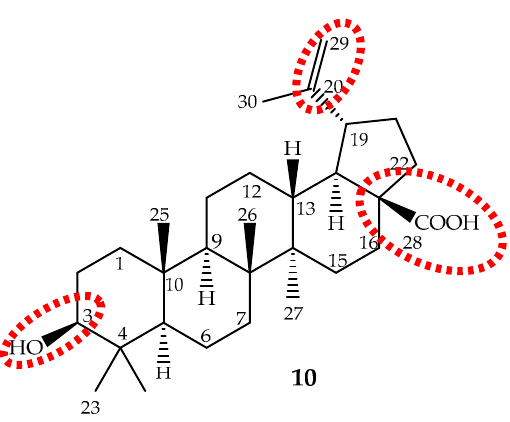
Figure 7. The chemical structure of the pentacyclic triterpene betulinic acid ( 10 ) and the main target to structural modifications (red).